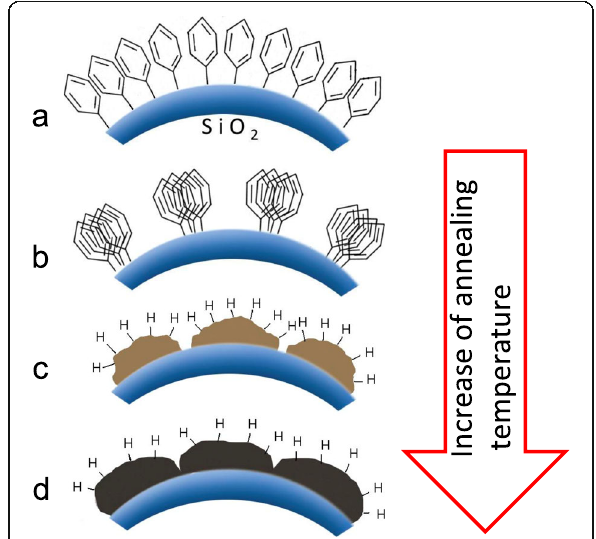
Fig. 7 The structural modification of the carbon layer structure in SiO 2 :C with increase of the temperature annealing. a Initial SiO 2 :C. b T ann = 500 °C. c T ann = 700 °C. d T ann = 800